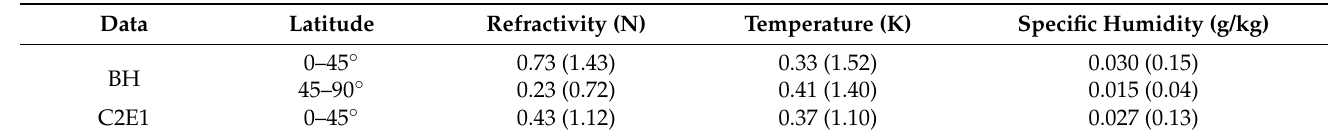
Table 1. The average absolute bias and STD for BH and C2E1 RO data at latitudes of 0–45 ◦ and 45–90 ◦ . The numbers in parentheses indicate STD values.